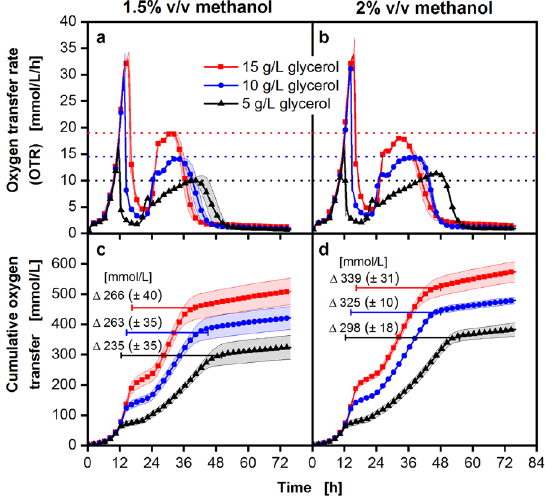
Figure 2. Cultivation of P. pastoris Mut S reference strain at different glycerol and methanol concentrations in microtiter plates with simultaneous online monitoring of the oxygen transfer rate (OTR). Cultivation was carried out in a 96-square well microtiter plate, 0.6 mL filling volume per well, 350 rpm and 50 mm shaking diameter, in a µTOM device 34 . The OTR is depicted for cultivations with 5, 10 and 15 g/L glycerol, using auto-induction conditions, with ( a ) 1.5% v/v methanol and ( b ) 2% v/v methanol added at the beginning of the cultivation. The cumulative oxygen transfer for the 1.5% v/v conditions is depicted in ( c ) and for the 2% v/v methanol conditions in ( d ). In all panels, for clarity, only every 4th data point is displayed. Shadows symbolize the standard deviation of cultivation replicates (N = 3). The dotted horizontal lines in ( a ) and ( b ) mark the maximum OTR value of ( a ) for the tested conditions during phase III: methanol consumption phase. Additionally, the volumetric oxygen amount consumed during growth on methanol is displayed for the different bars in ( c ) and ( d ) mark the duration of phase II and III. The obtained value corresponds to the total volumetric amount of oxygen consumed in phases II and III (see Fig. 1). Cultivation conditions: mineral Syn6 medium